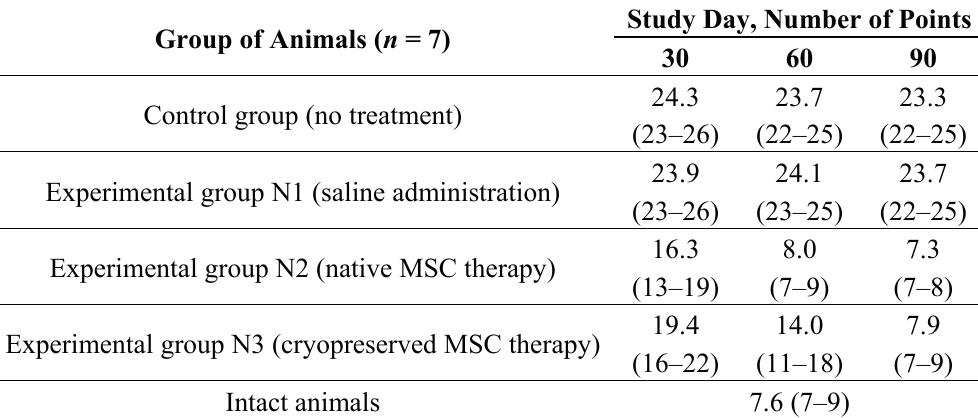
Table 2. Integrated semi-quantitative histological analysis of the AF tissue after MSC transplantation (the total score). The limit values of the parameter for the corresponding group of animals are shown in parentheses.